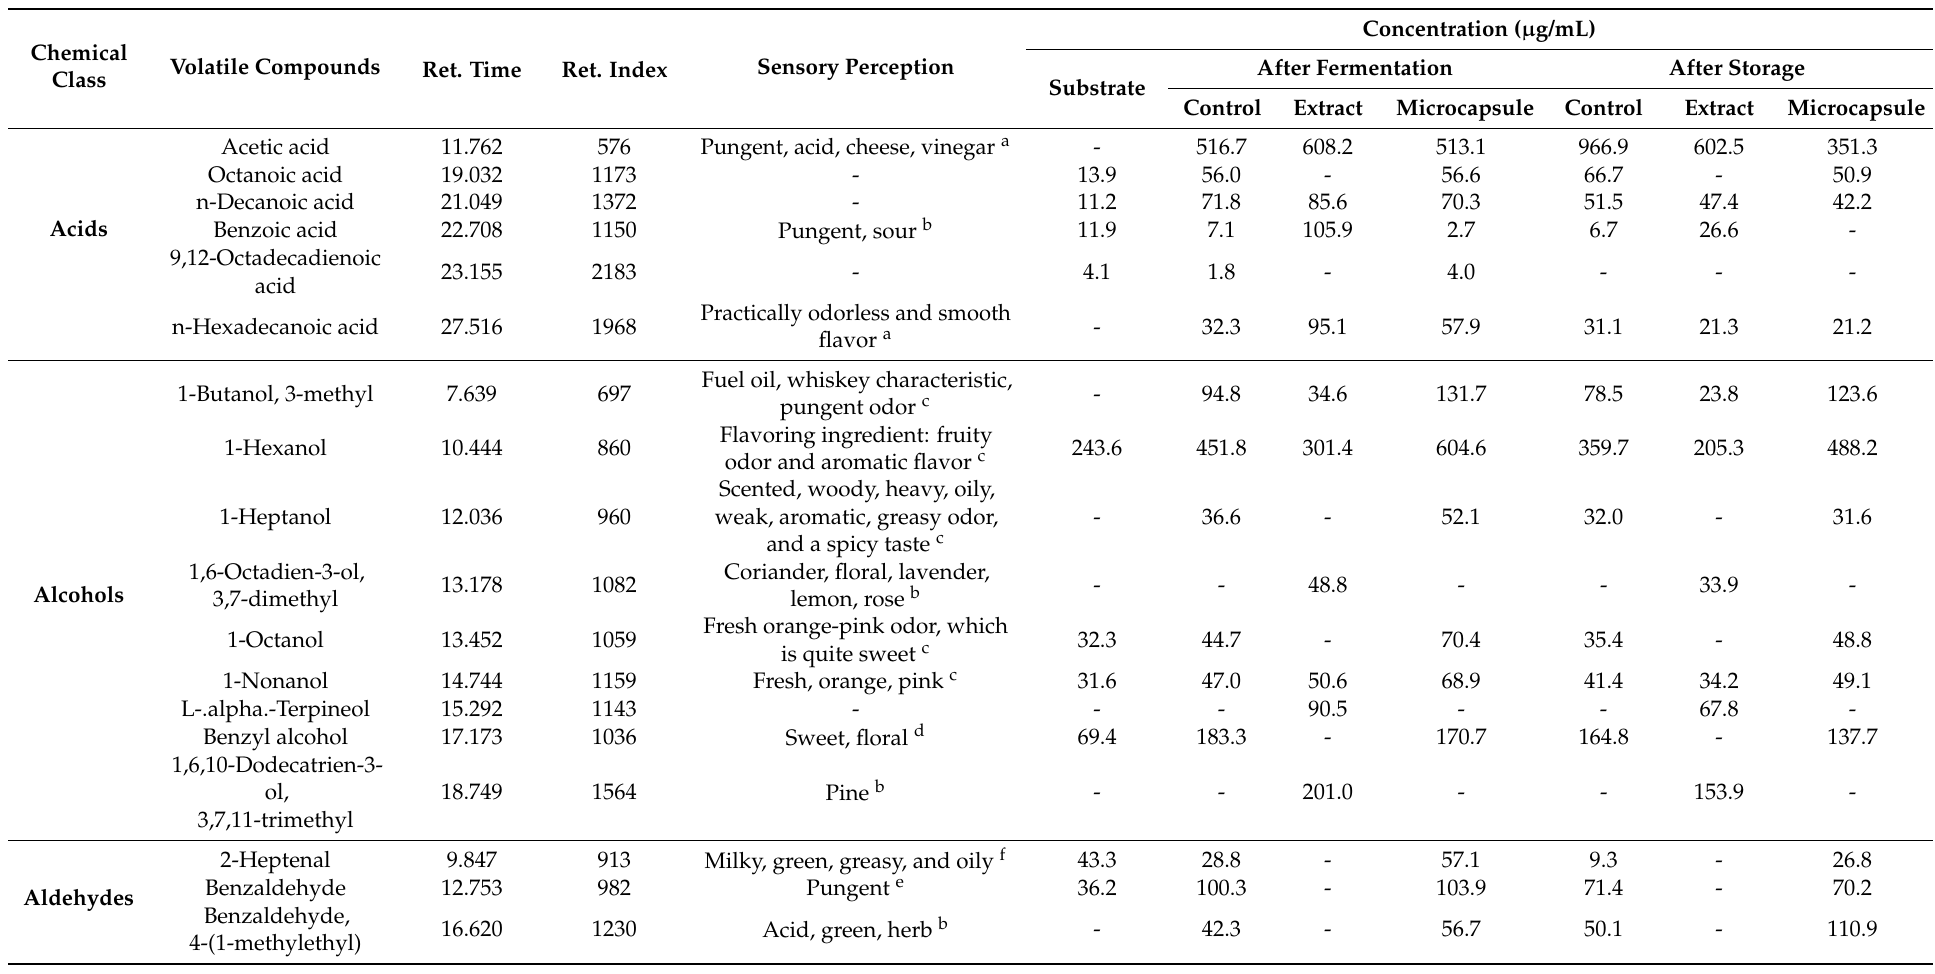
Table 2. Volatile compounds identified by GC-MS analysis at the beginning (substrate), after fermentation (48 h, 24 h fermentation + 24h after adding propolis), and at the end of storage (28 days) (Figure